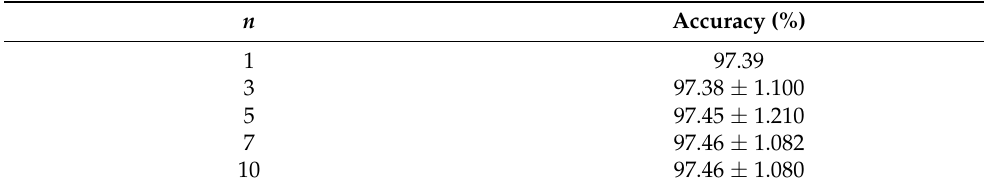
Table 7. Results of N -fold